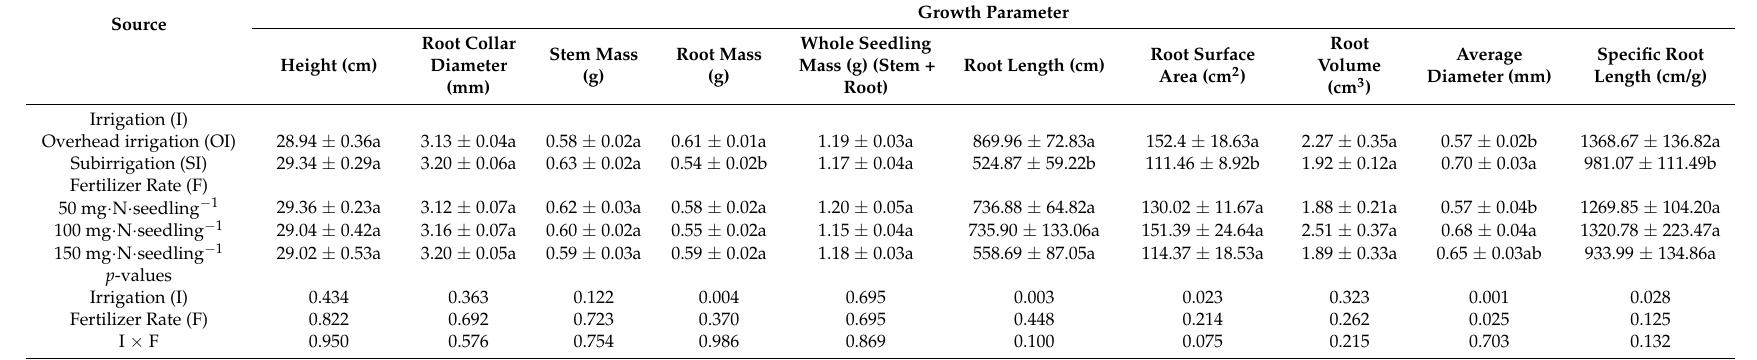
Table 1. Larch seedling morphology at time of final harvest (203 days after sowing; 10 November). Column means ± SE followed by different letters within a given treatment differ significantly according to Tukey’s honestly significant difference test at α = 0.05. P -values for main effects of irrigation and fertilizer rate and their interaction on larch seedling morphology at time of final